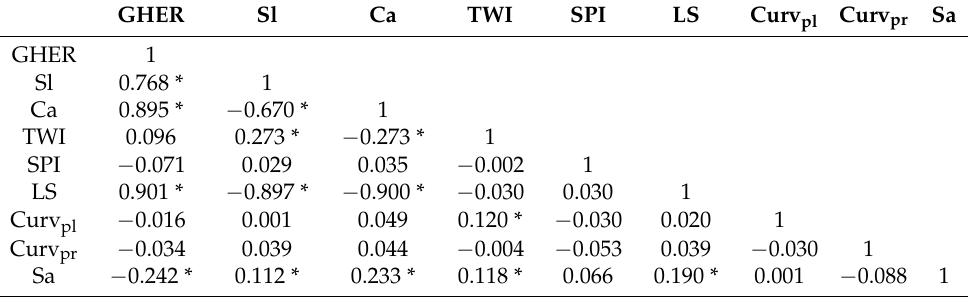
Table 2. Spearman’s rank correlation coefficient among terrain attributes (n =